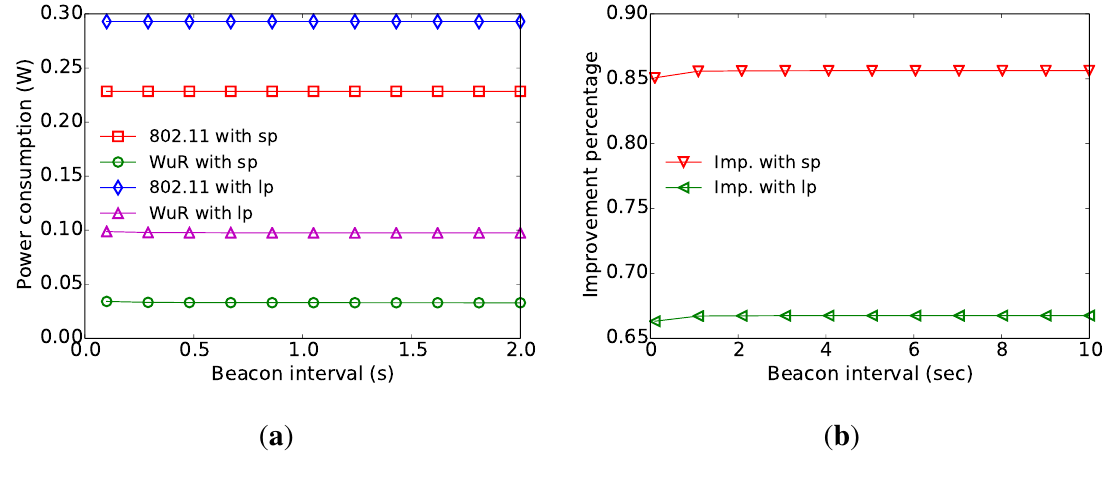
Figure 8. Power consumption is a function of beacon interval. ( a ) Power consumption versus beacon interval; ( b ) improvement on power consumption versus beacon